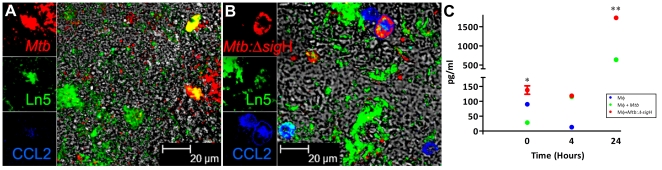
Comparison of the expression of CCL2 in Rh-BMDM infected with Mtb or Mtb: Δ-sigH at the protein level.Visualization of the production of chemokine CCL2 (blue) in Mtb (A) or Mtb:Δ-sigH (B) (both in red) - exposed (Ln5+) macrophages (green) by multilabel confocal microscopy. CCL2 production measured by ELISA (C). Levels of CCL2 were determined in the supernatants of Rh-BMDMs with Mtb or Mtb:Δ-sigH by multiplex ELISA. The figure shows the arithmetic means ± standard deviations for three biological replicates. *, p<0.05; **, p<0.01, ***, p<0.001 and ****, p<0.0001.